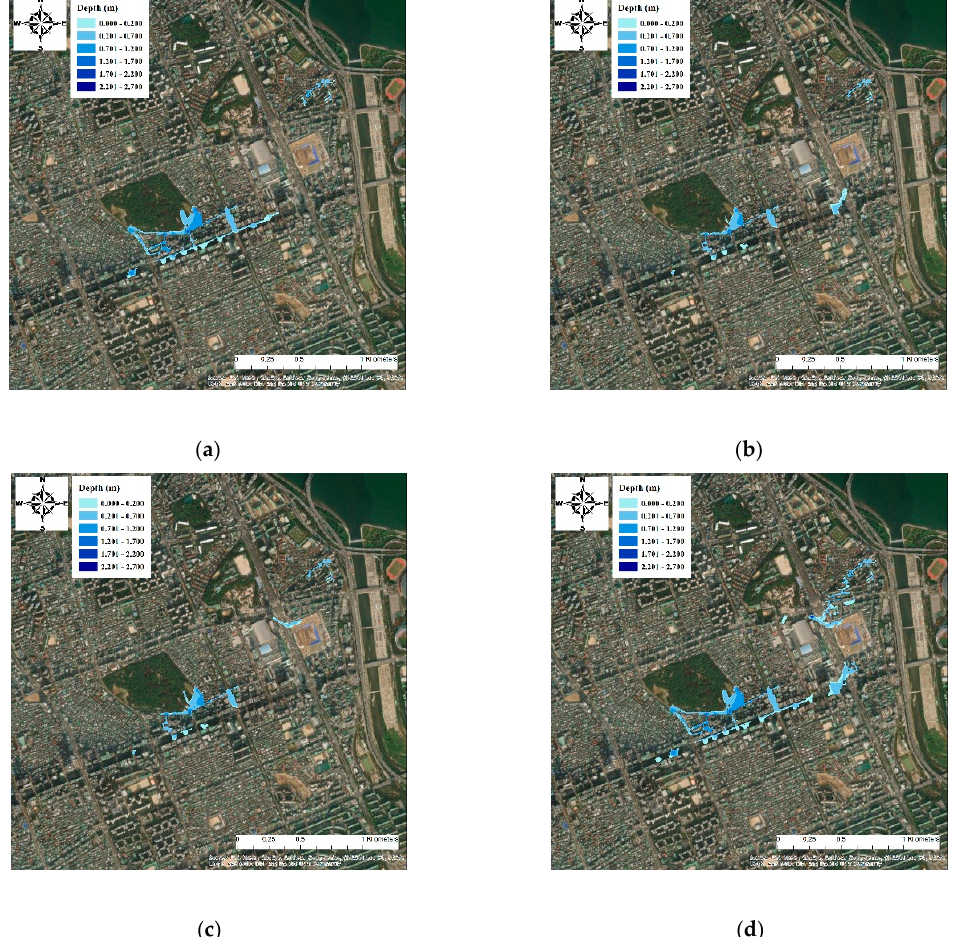
Figure 8. Sample maximum inundation maps applying 100-year, 1-h rainfall events with different Huff quartile distributions (( a – d ): 1st, 2nd, 3rd, and 4th quartile).